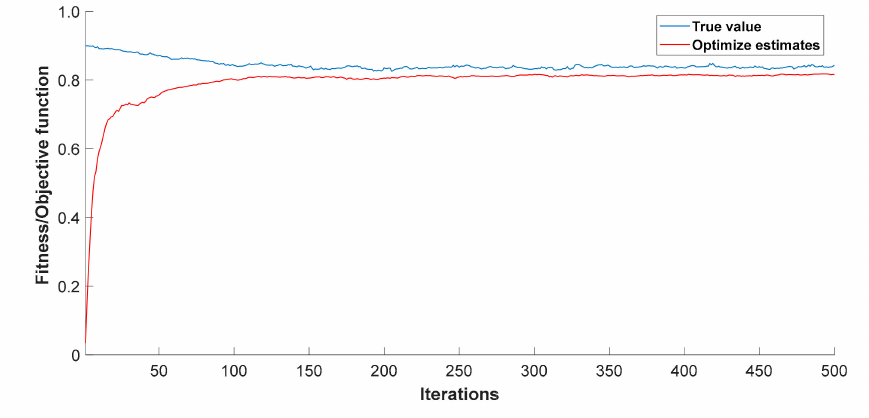
Figure 4. Optimized fitness curve.